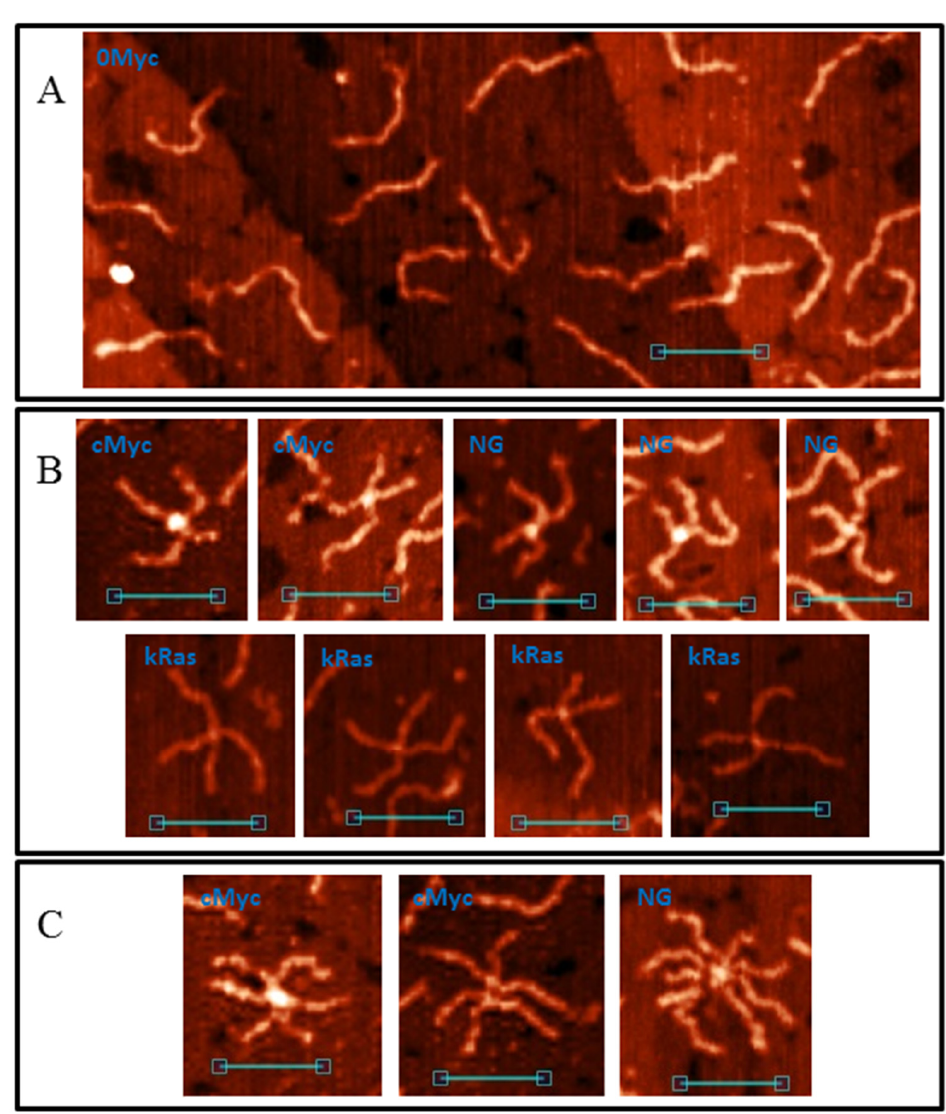
Figure 1. AFM images of natural dsDNA fragments. ( A ) AFM image of 0Myc duplex; ( B ) Cruciform structures, formed by PQS-containing duplexes; ( C ) Complex G4/IM-synaptic complexes formed by more than two molecules. Scale bars: 50 nm.